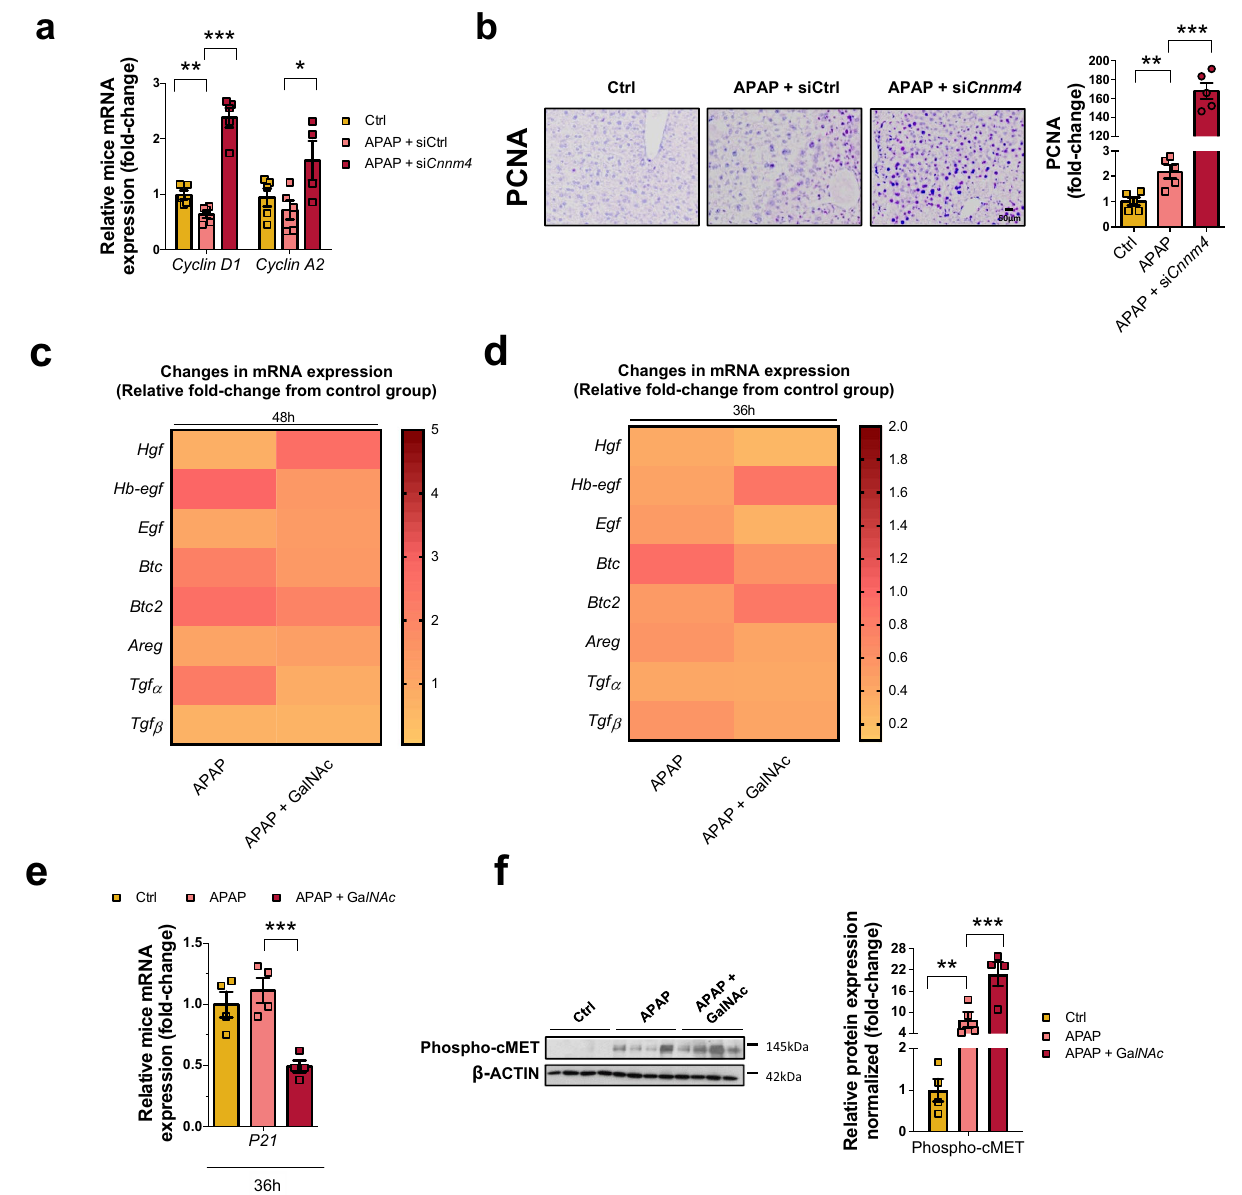
Fig. 7 | Cnnm4 knockdown induced liver regeneration in preclinical APAP model. a mRNA levels of Cyclin D1 and Cyclin D2 . Values are represented as mean±SEM. ** P <0.01; *** P <0.001 (Cyclin D1 P =0.01 APAP vs Ctrl; P =1.31E-05 APAP+si Cnnm4 vsAPAP)(CyclinD2 P =0.042APAP+si Cnnm4 vsAPAP)(Student ’ s test, two-sided). b PCNA expression by immunohistochemistry. Scale bar corre- spondsto50 µ minWTmicetreated for48hwithAPAP( n =5)andsilenced Cnnm4 by siRNA the last 24h of the hepatotoxic ( n =5). Changes in mRNA levels of Hepatocyte Growth Factor( Hgf), Heparin Binding EGF Like Growth Factor (Hb-egf) , EpidermalGrowthFactor (Egf),Betacellulin(Btc),Betacellulinv2(Btc2),Amphiregulin (Areg), Transforming Growth Factor Alpha (Tgf α ), and Transforming Growth Factor Beta (Tgf β ) in c . WT mice treated with a single dose of APAP 360mg/kg for 48h ( n =5) and treated with a si Cnnm4 for the last 24h ( n =5) and d WT mice treated